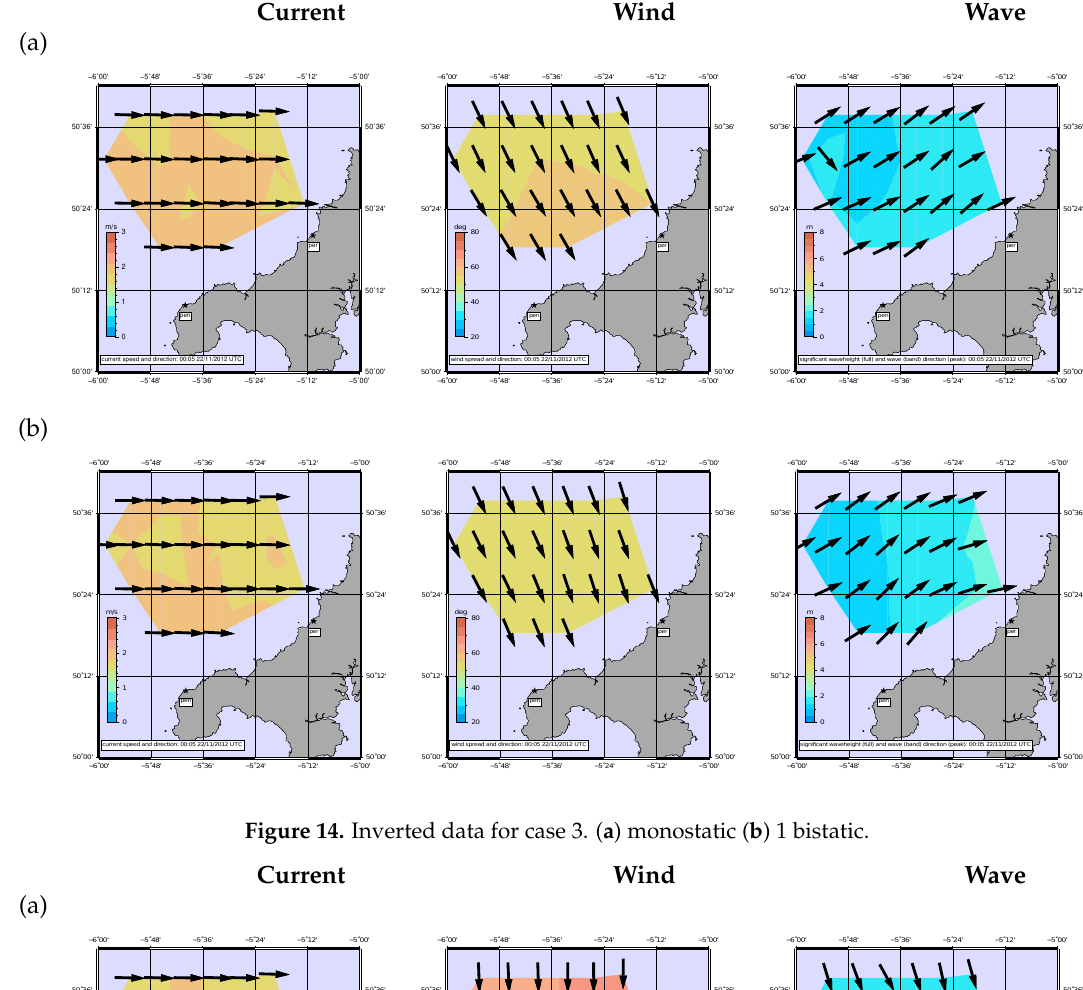
Figure 14. Inverted data for case 3. ( a ) monostatic ( b ) 1 bistatic. Current Wind Wave